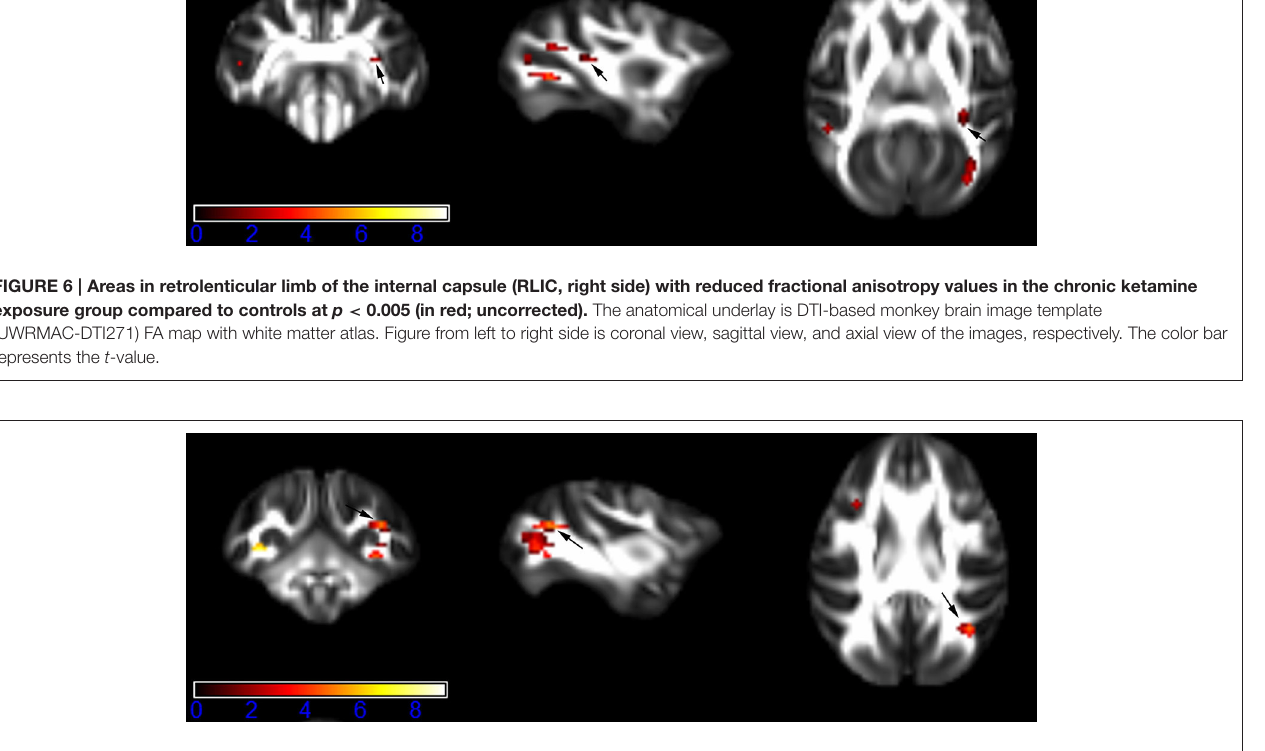
FIGURE 7 | Areas in superior longitudinal fasciculus (SLF, right side) with reduced fractional anisotropy values in the chronic ketamine exposure group compared to controls at p < 0.005 (in red; uncorrected). The anatomical underlay is DTI-based monkey brain image template (UWRMAC-DTI271) FA map with white matter atlas. Figure from left to right side is coronal view, sagittal view, and axial view of the images, respectively. The color bar represents the t